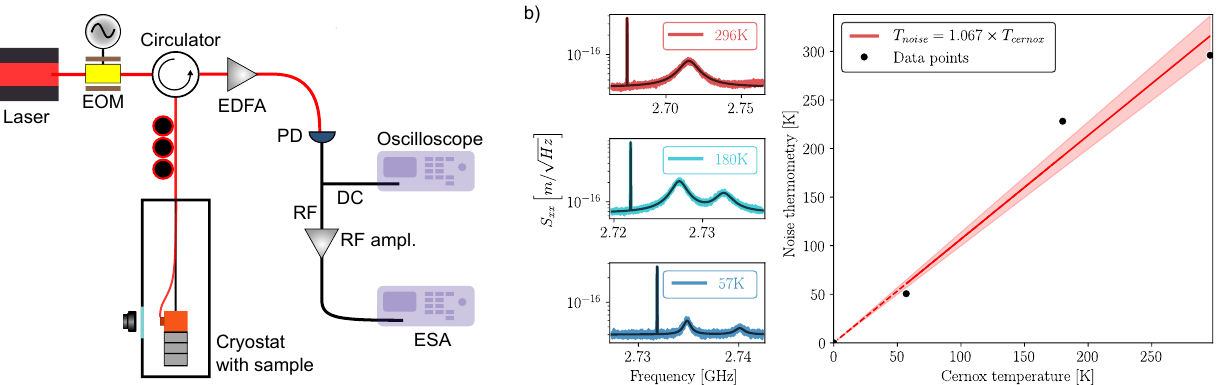
Figure 10. ( a ) Schematic of the calibrated noise-thermometry measurement setup. The optome- chanical crystal is placed in a 4 He cryostat. The acquisition of the Brownian motion spectra, via the electrical spectrum analyzer (ESA), relies on the side of fringe measurement scheme. EOM: Electro-optical phase modulator; EDFA: Erbium-Doped Fiber Amplifier; PD: High-speed photodiode; ( b ) Left: Brownian motion spectra with their calibration tone at different temperatures. Right: Ex- tracted temperature from the ratio of the areas of the Brownian motion and calibration peaks. The red curve is a linear fit to the extracted